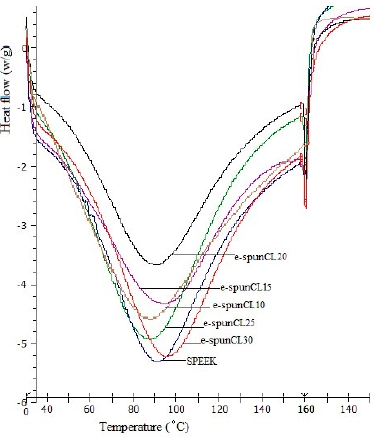
Figure 8. DSC curves heating for SP/e-spunCL and SPEEK membranes.